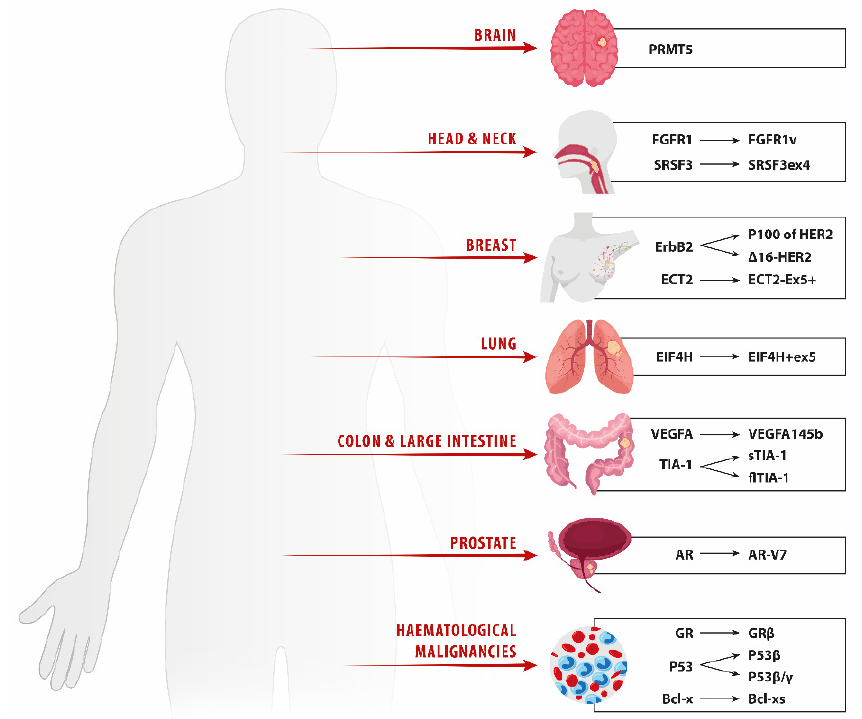
Figure 3. Cancer-related genes undergoing AS and their significance for drug resistance. The figure summarizes representative AS events that contribute to chemotherapy failure in different cancers. PRMT5 (Protein Arginine Methyltransferase 5); FGFR1 (Fibroblast Growth Factor Receptor 1); SRSF3 (Serine and Arginine Rich Splicing Factor 3); ErbB2 (Erb-B2 Receptor Tyrosine Kinase 2); EIF4H (Eukaryotic Translation Initiation Factor 4H); VEGFA (Vascular Endothelial Growth Factor A); TIA-1 (TIA1 Cytotoxic Granule Associated RNA Binding Protein); AR (Androgen Receptor); GR (Glucocorticoid receptor); P53 (Tumor Protein P53); Bcl-x (BCL2 Apoptosis Regulator).